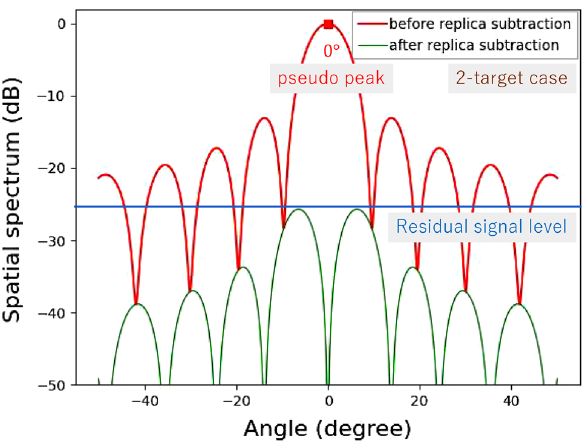
Figure 4. Computationally obtained spatial spectra in the presence of two angularly close targets.